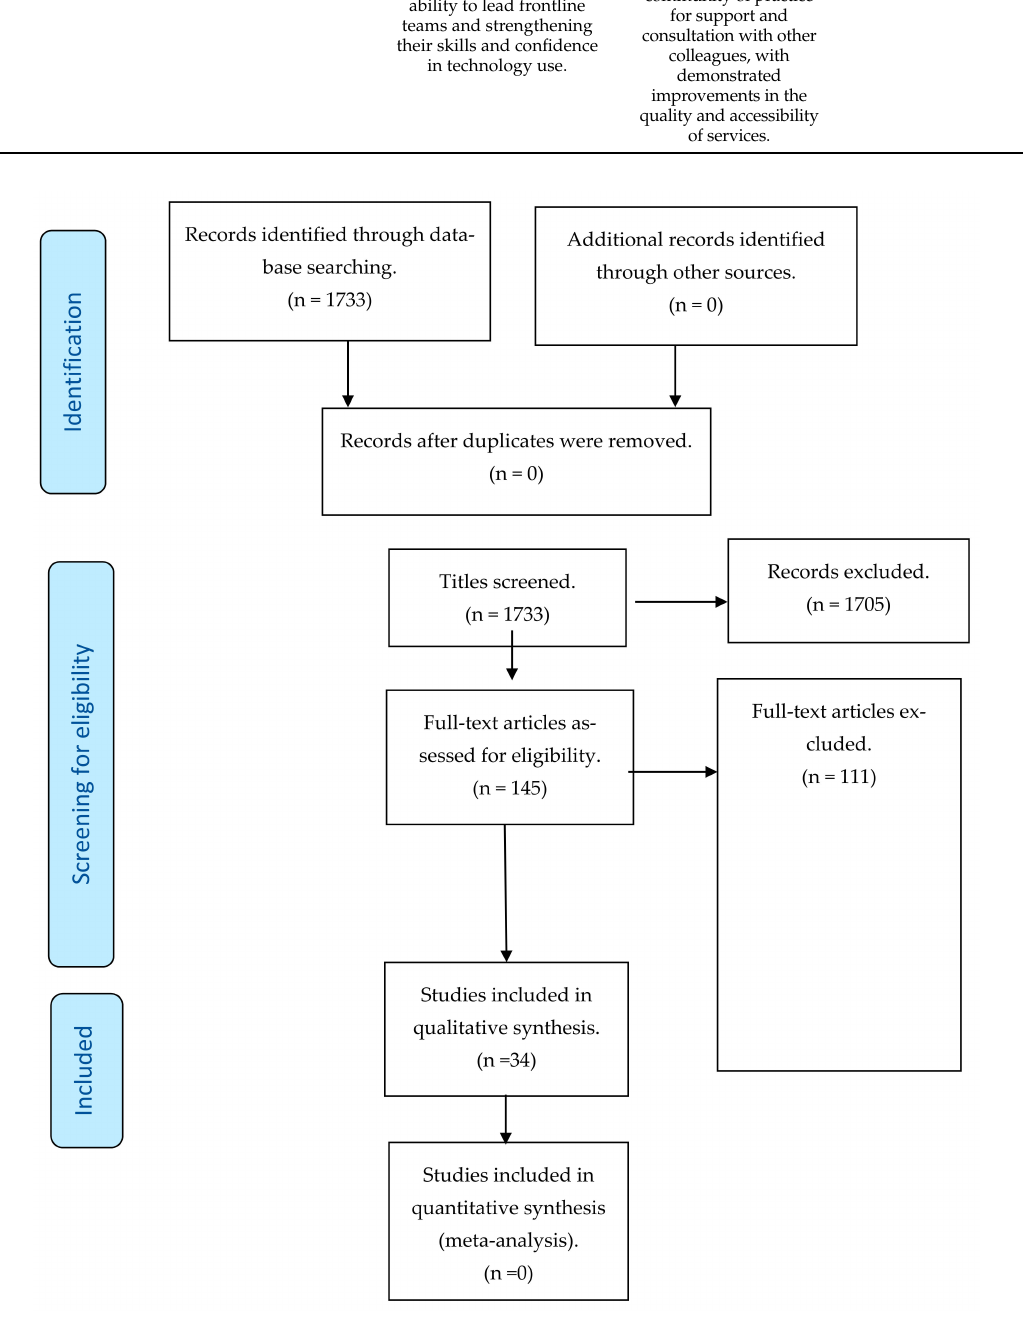
Figure 1. Study selection process for the scoping